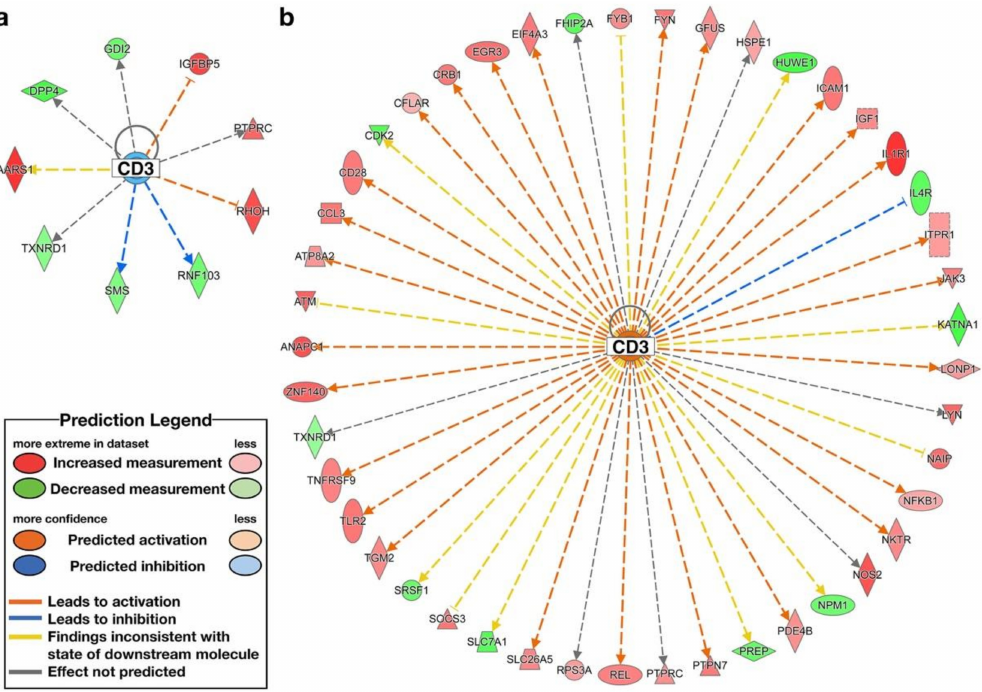
Figure 7. Differentially expressed genes (FDR adjusted p -value < 0.05) contributing to the identifica- tion of the upstream regulator, cluster of differentiation 3 (CD3) following lignan flaxseed intervention: ( a ) no statistically significant effect in high-ENL excreters (z-score − 1.342); ( b ) predicted activation of CD3 in low-ENL excreters (z-score 2.802).